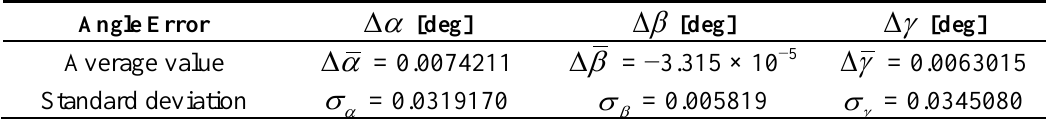
Table 2. Euler angle errors between frames { E } and { E ’} for 30 robot